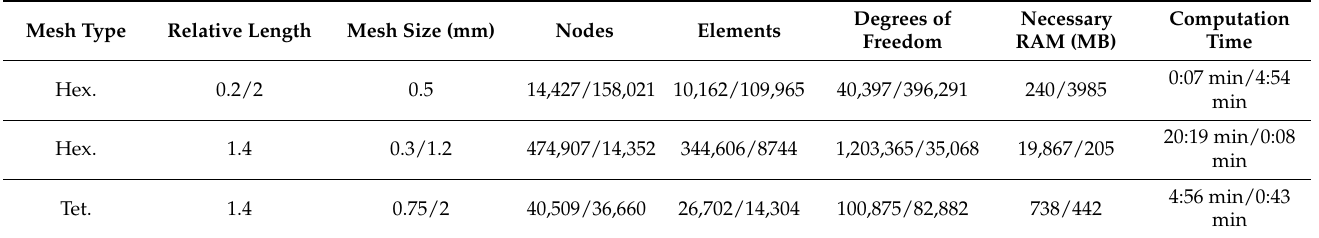
Table 4. Information on the model size, necessary RAM to load the full stiffness matrix, and compu-